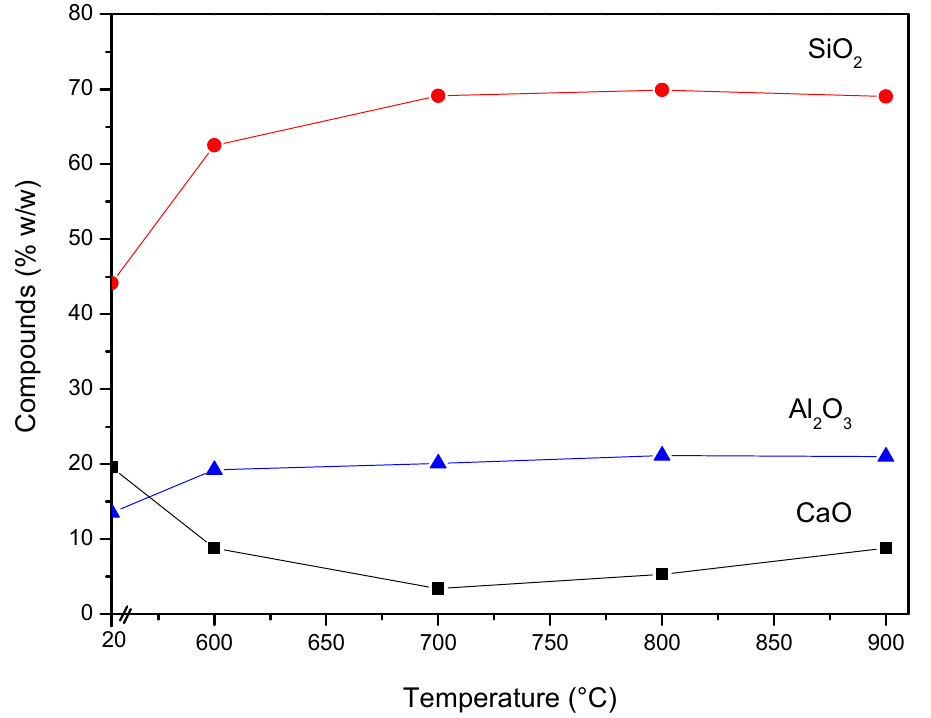
Figure 7. Content of SiO 2 , Al 2 O 3 and CaO in residues of the Mi sample calcined in Cl 2 (g) at different temperatures for 120 min.